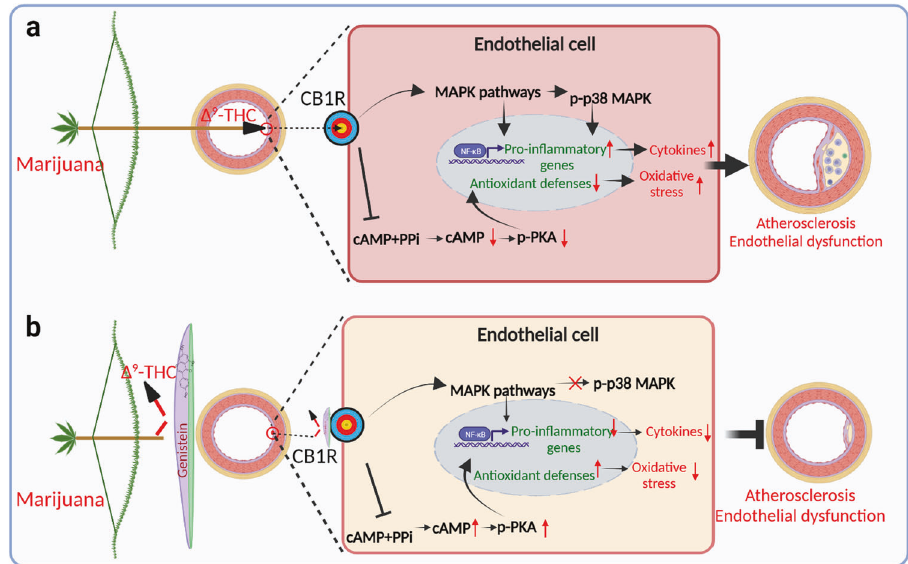
Fig. 1 Protective effect of genistein on Δ 9-THC-induced endothelial dysfunction in atherosclerosis. a △ 9-THC binds and activates the CB1R signaling, which activation causes in fl ammation and oxidative stress leading to endothelial dysfunctions in atherosclerosis through inducing PKA, p38 MAPK and NF- κ B signaling pathways. b CB1R antagonist genistein alleviates the △ 9-THC-induced deleterious effects in endothelial cells, which suggest that genistein has promising therapeutic